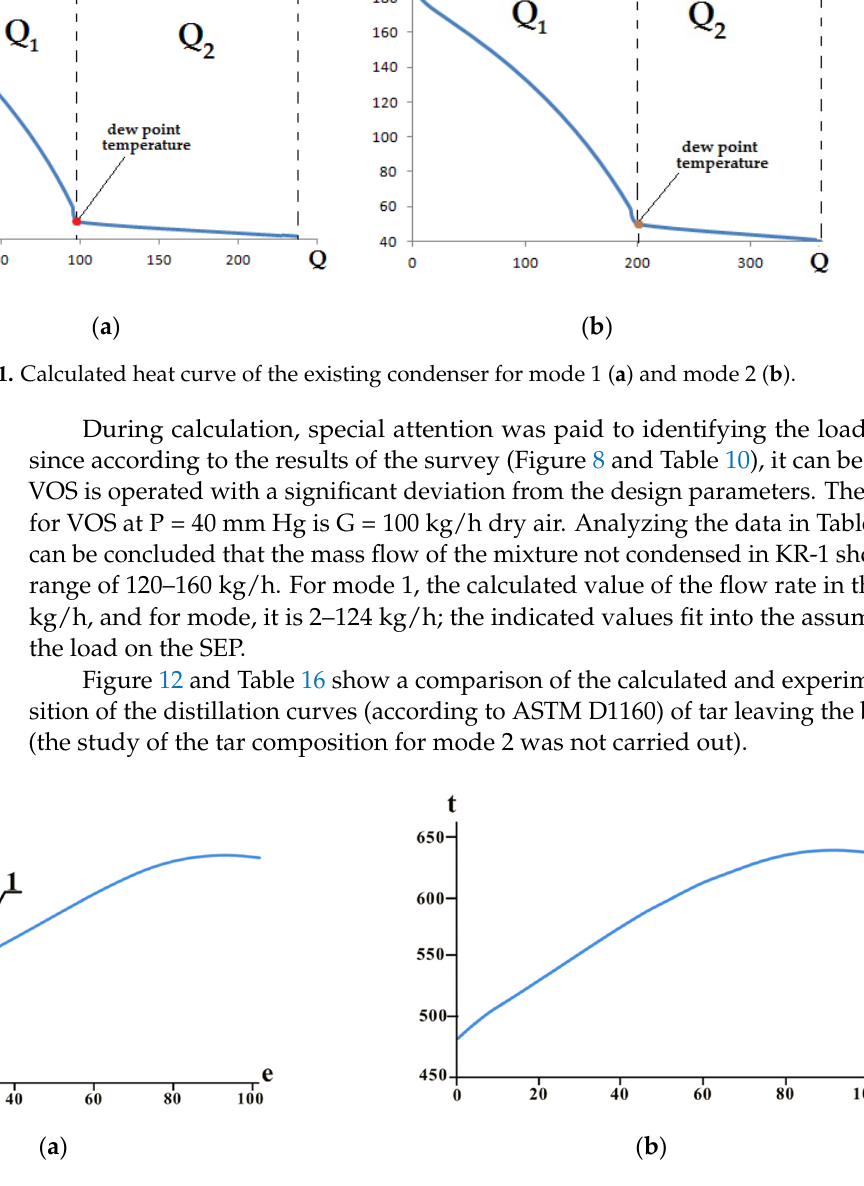
Figure 12. Calculated 1 and experimental curves 2 of distillation of tar for mode 1 ( a ) and mode 2 ( b ). Table 16. Calculated values of the tar distillation curve.